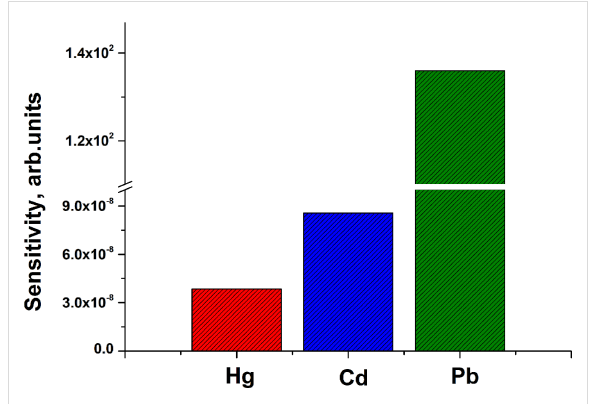
Figure 10: Histogram plot of graphene/SiC device sensitivity (at fixed voltage of 1 V) towards different heavy metals.